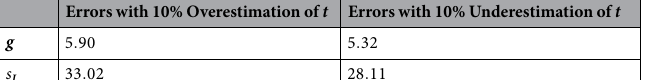
for the 100 data points reported in l will be overes- l